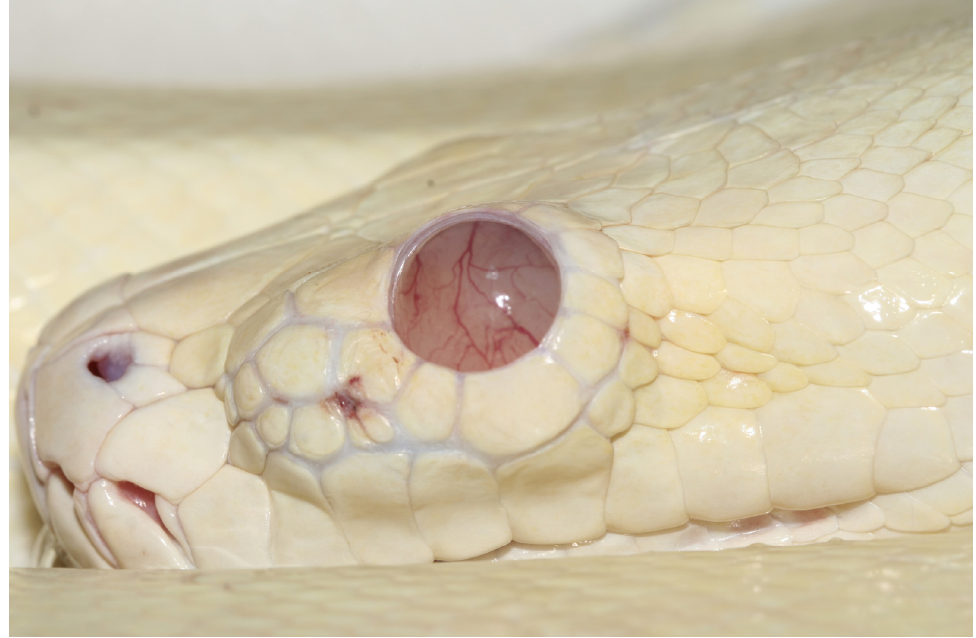
Figure 7. Engorged spectacular vessels in a Burmese python ( Python bivittatus ) with chronic pseu- dopubhthalmos. Besides overfilling of the subspectacular space, prominent swelling of the perioc- ular and facial region can be noted.